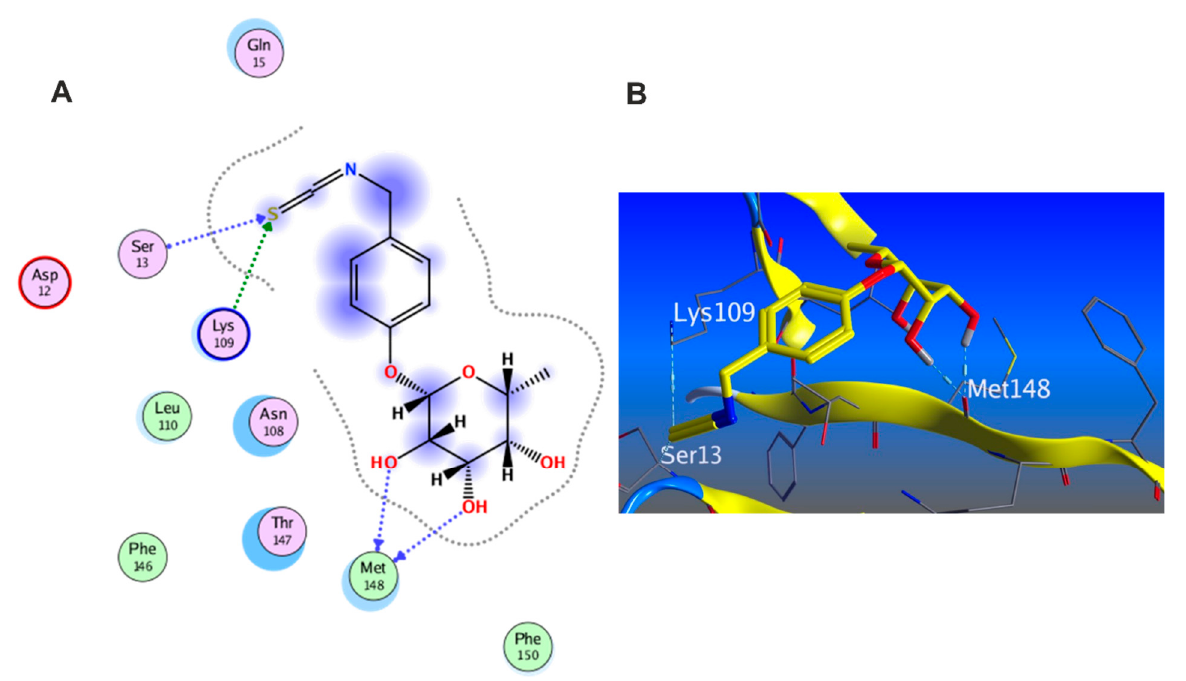
Figure 16. Docking results of compound 15 in the active pocket site of IL-1 β (PDB:6Y8M): ( A ) 2D interactions of compound 15 ( B ) 3D Docking pose of compound 15 .